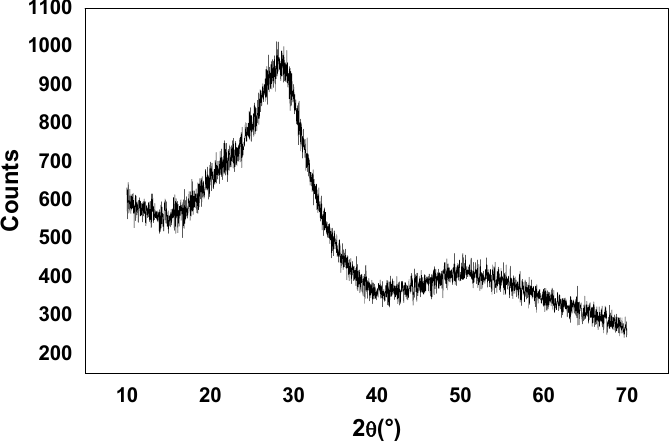
Figure 2. X-ray diffraction pattern of the TZV5 glass.